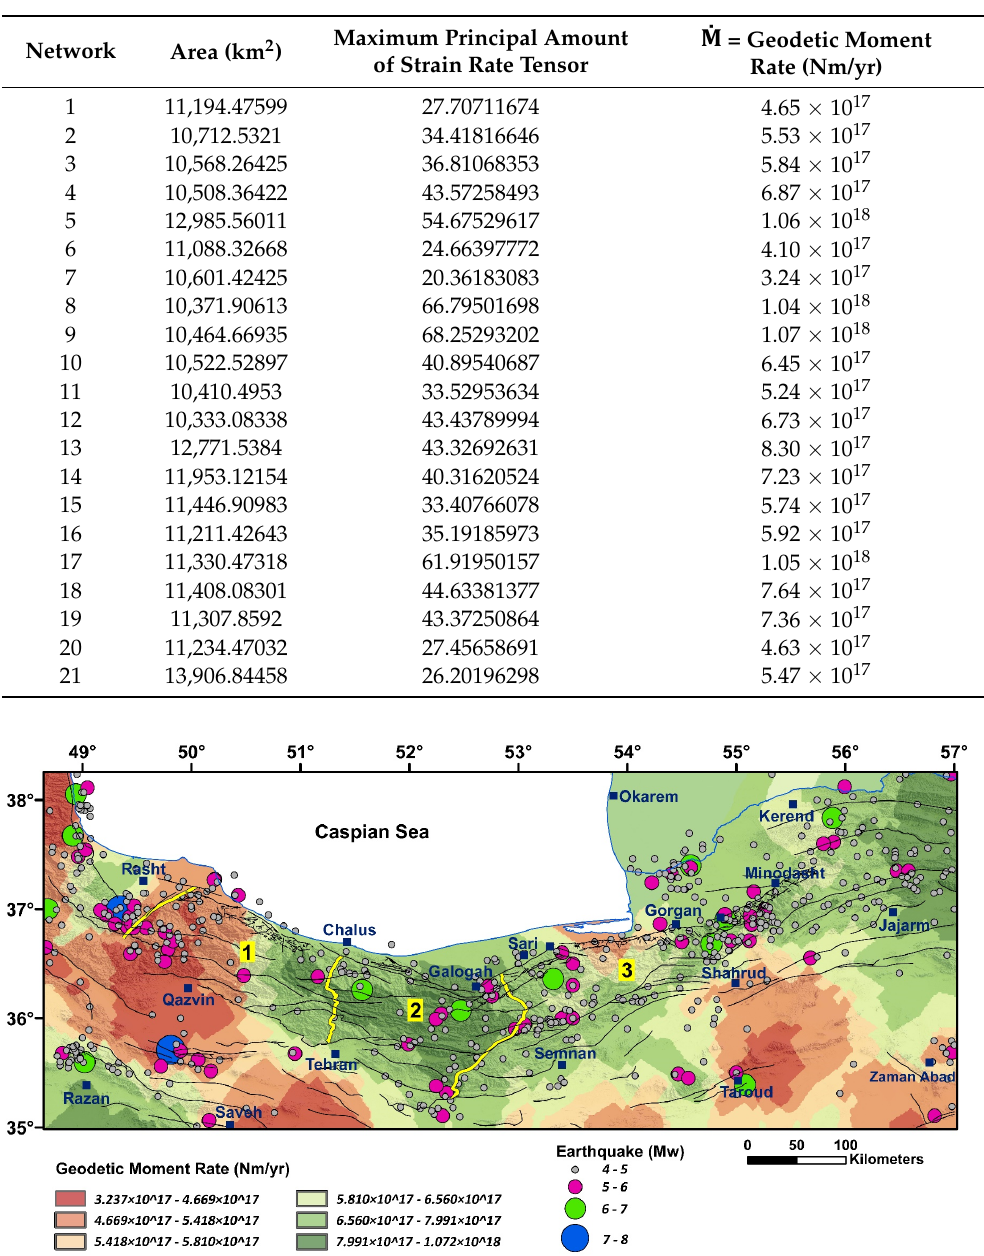
Table 8. The maximum principal amount (eigenvalues) of the strain rate tensor, and geodetic moment rates in the area.